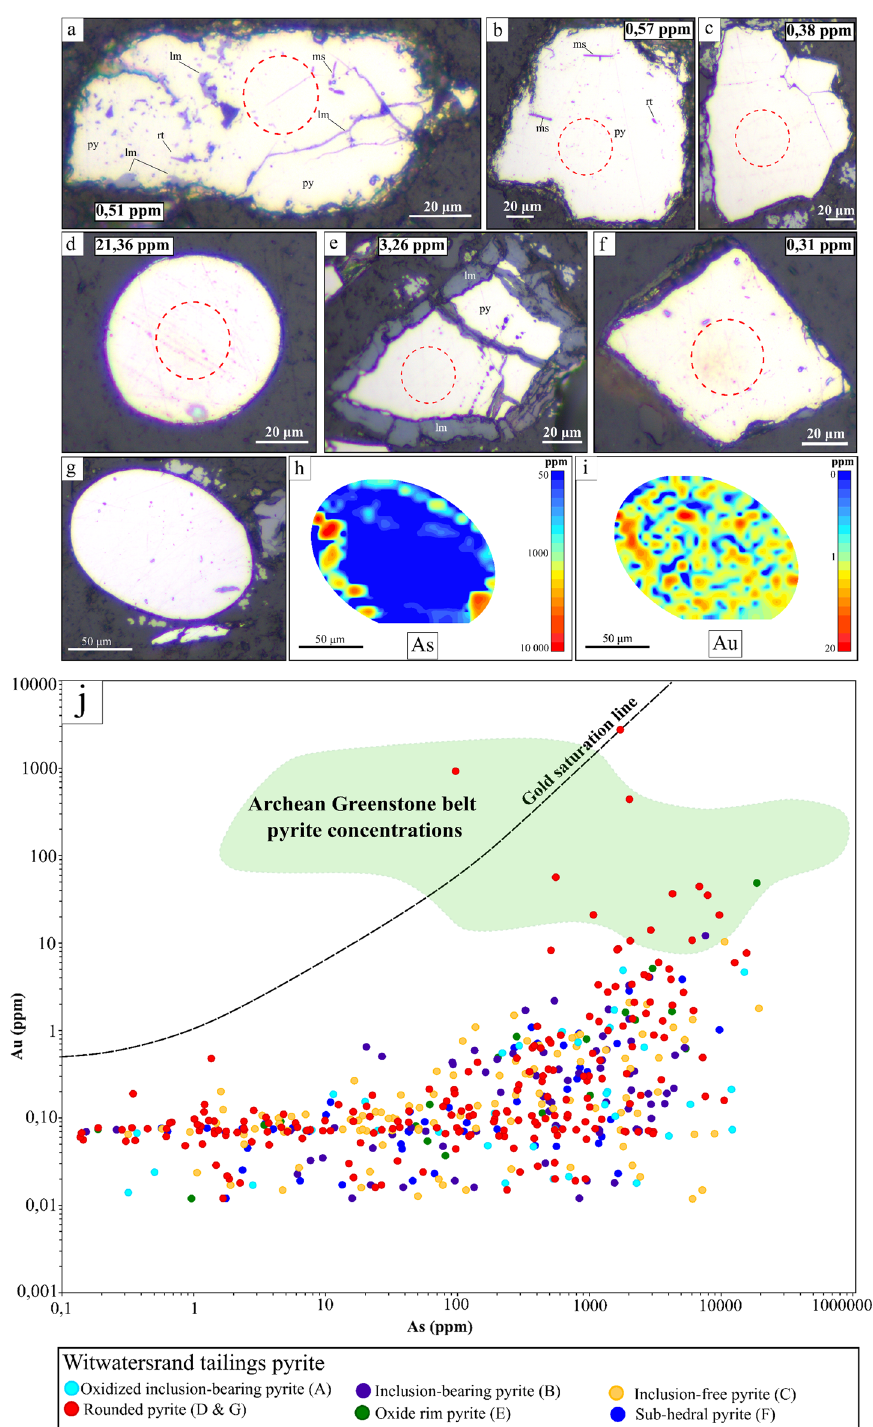
Figure 3. ( a-h) Optical images of the six pyrite types classified according to morphology and texture that are found within the heavy mineral fraction of the Witwatersrand tailings dumps. The ablation spot on the grain and the resultant mean gold concentrations are also presented. ( a ) An oxidized inclusion-bearing anhedral pyrite with inclusions of muscovite, rutile and limonite. ( b ) A fresh inclusion-bearing anhedral pyrite ( c ) A fresh inclusion-free anhedral pyrite ( d ) A fresh rounded anhedral pyrite ( e ) An oxide rim anhedral pyrite. ( f ) A fresh cubic inclusion-free euhedral/subhedral pyrite. ( g ) Shows a rounded detrital pyrite grain from the tailings dump material with corresponding LA ICP-MS maps of ( h ) gold and ( i ) arsenic. ( j ) A logarithmic plot of the concentration relationship between gold and arsenic within the different classes of pyrite from the heavy mineral fraction of the Witwatersrand tailings dump material. The gold/arsenic concentration field of auriferous pyrite from gold reefs in the Barberton Greenstone Belt has also been plotted 24,57,58 . The gold saturation line proposed for pyrite in gold deposits represents the maximum limitations for gold in solid solution within the pyrite structure, pyrite plotting above the line will have gold as free gold inclusions 22